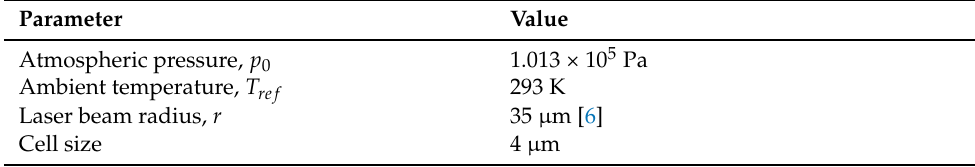
Table 2. Parameters for thermo-fluid flow model.